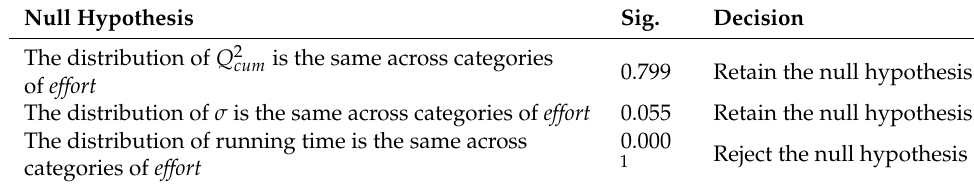
Table 3. Independent-samples Kruskal–Wallis test summary.